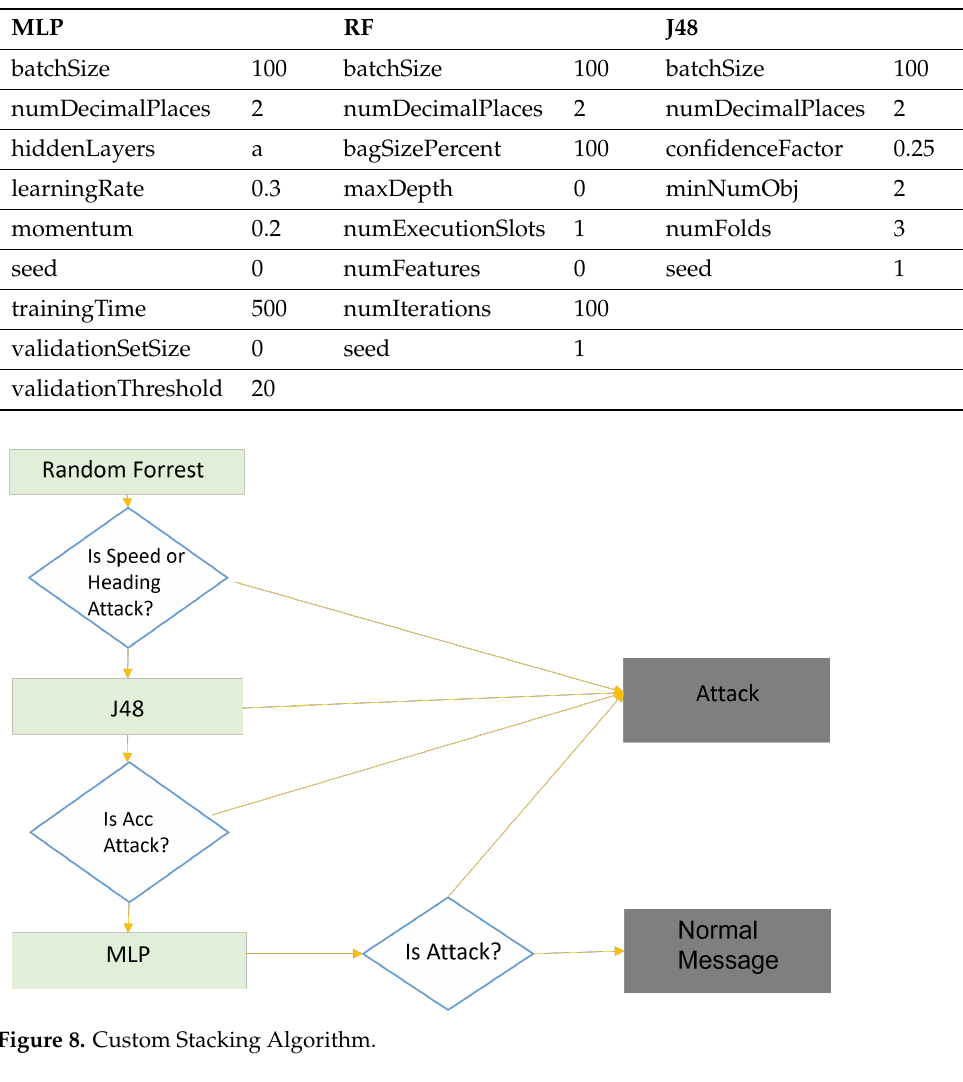
Table 7. Configuration of the algorithms for the ensemble learning.